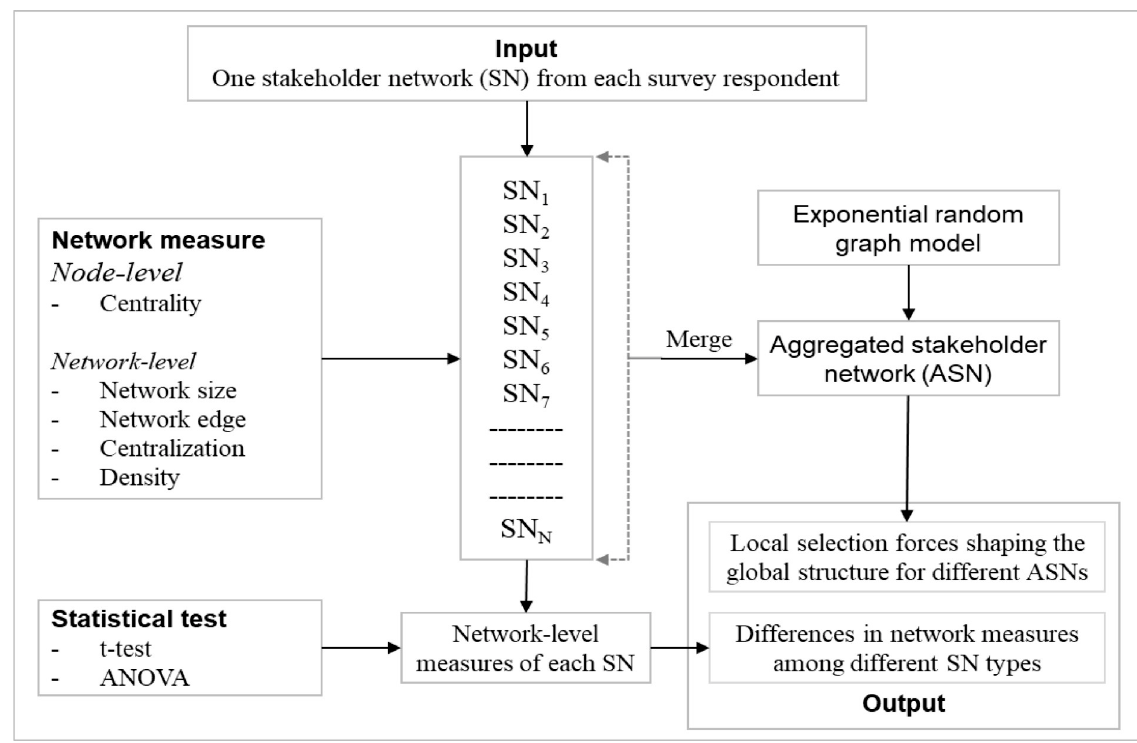
Fig 1. The research framework for investigating the stakeholder engagement